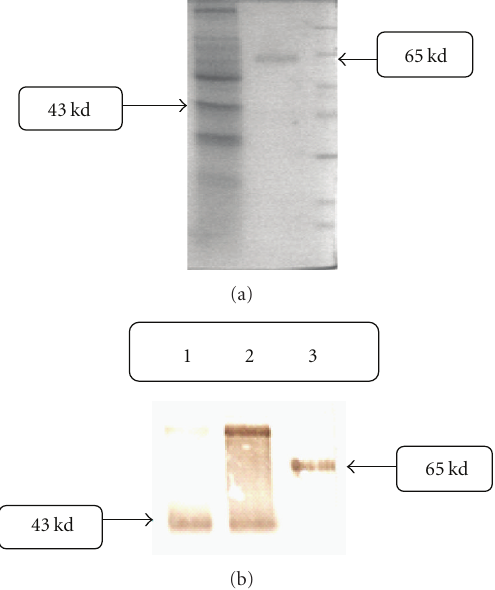
Figure 5: (a) SDS-PAGE analysis from supernatant of transfected CHO cells, 12% gel-coumasei blue stained. Right line: truncated t- PA CHO cell culture medium. Middle line: full length t-PA. Left line: protein marker. (b) Western Blot analysis from supernatant of transfected CHO cells. Lane 1&2: chimeric truncated t-PA CHO cell culture medium. Lane 3: full length